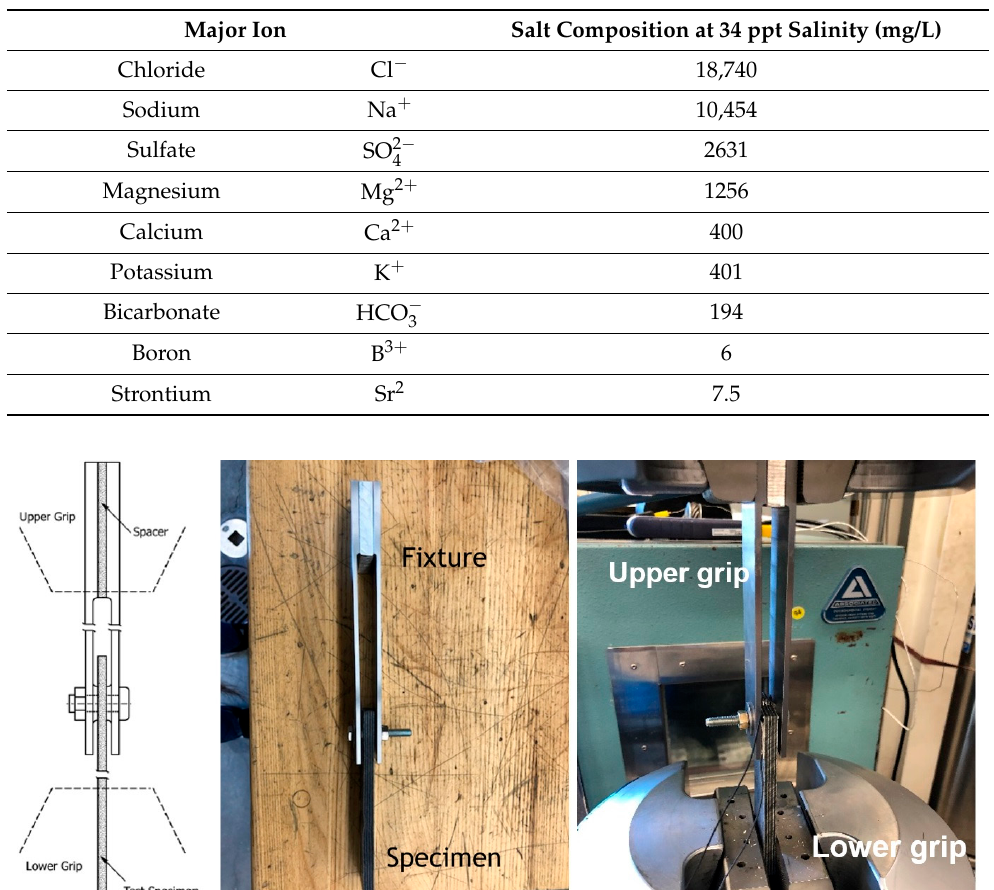
Table 1. Major ion composition of the salt water solution used to submerge test coupons.